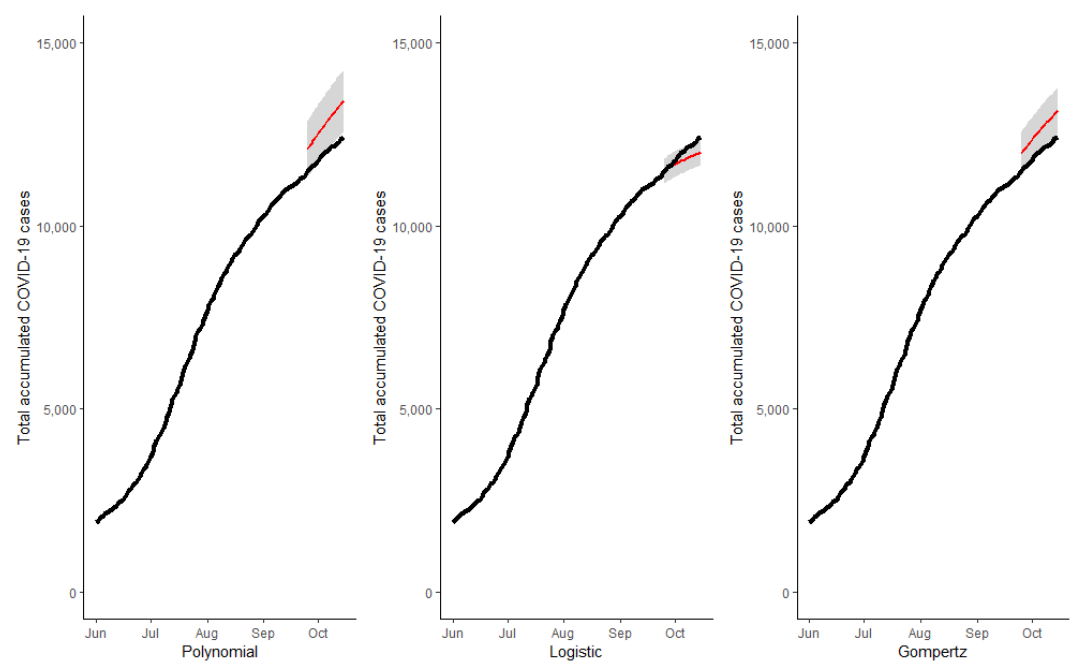
Figure 6. Forecast for total accumulated cases at 21 days for the state of Quintana Roo.